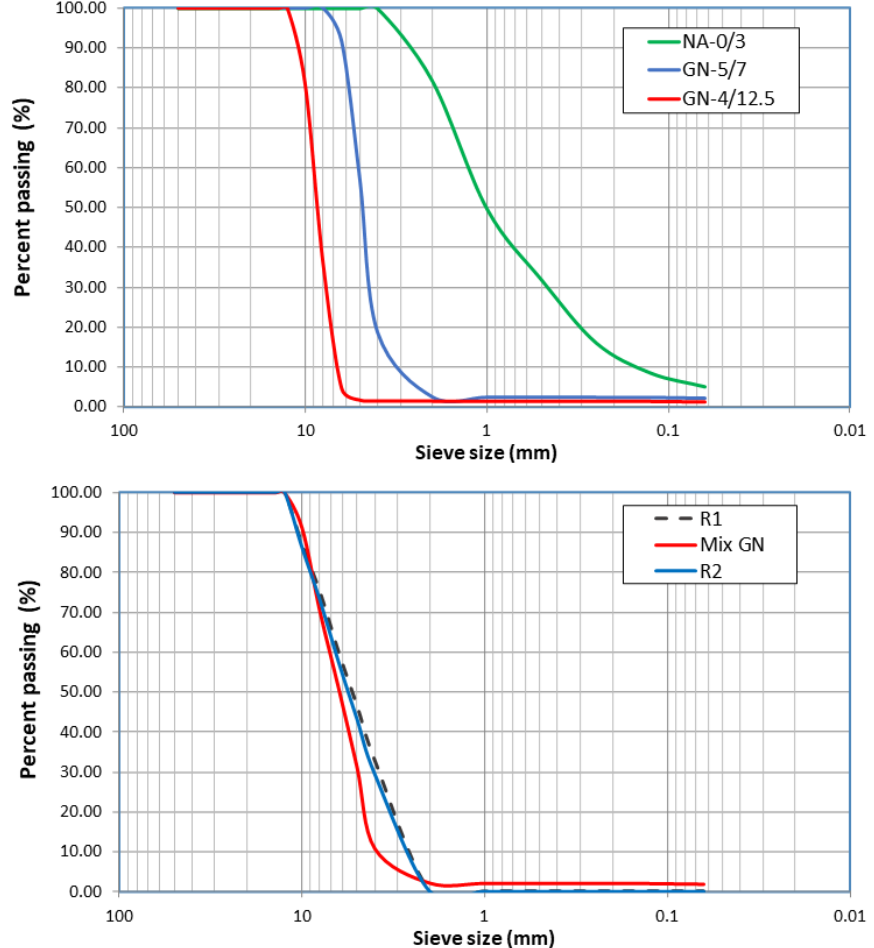
Figure 1. Particle size of natural aggregates, recycled aggregates and the reconstruction of the particle size used in the different mixtures.